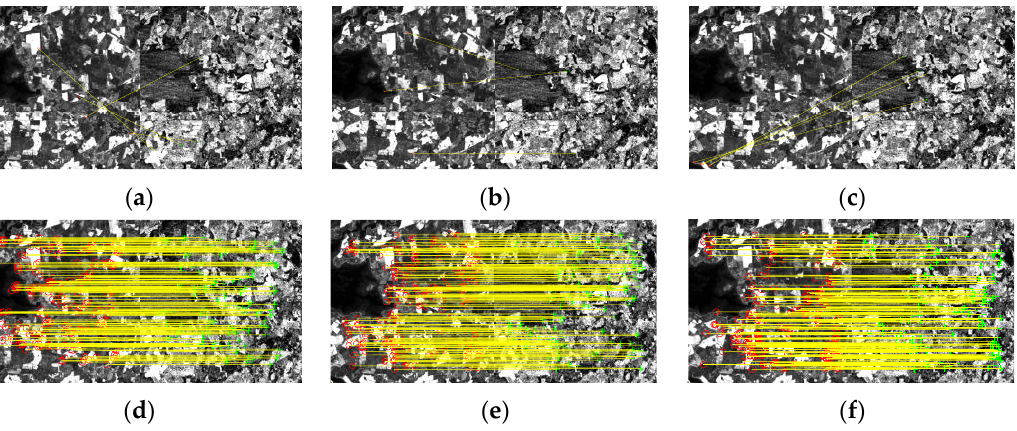
Figure 14. Experimental results of pair 2. The registration results from ( a ) to ( f ) are SIFT, SAR-SIFT, OS-SIFT, HOPC, RIFT, and MSPCO, respectively.